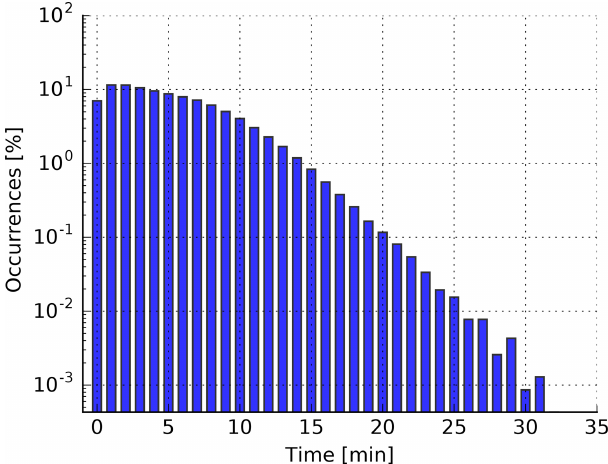
Figure 2. Histogram of the time that parcels spend in a cloud. For the sampling of the data, a threshold of 0.01gkg − 1 of the q c was used to separate cloudy from non-cloudy